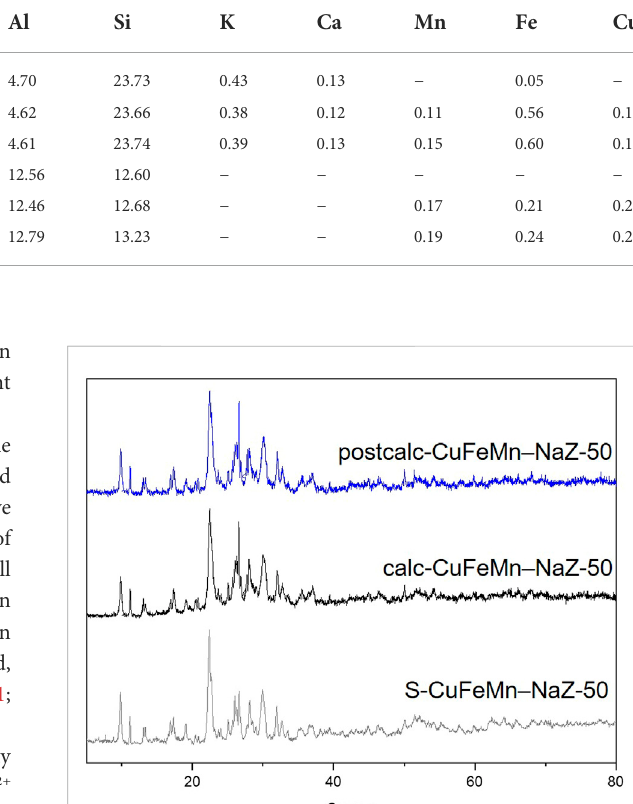
FIGURE 1 X-ray powder diffractograms of metal-modi fi ed S-CuFeMn – NaZ-50 (gray), calcined metal-loaded sample calc- CuFeMn – NaZ-50 (black) and calcined metal-loaded sample after catalytic test postcalc-CuFeMn – NaZ-50